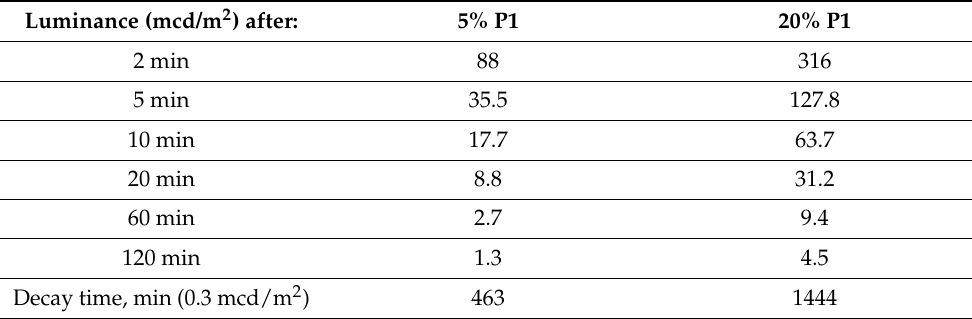
Table 5. Luminance decay obtained by samples coated with 20% of P2 pigment. Luminance (mcd/m 2 ) after: 20% P2